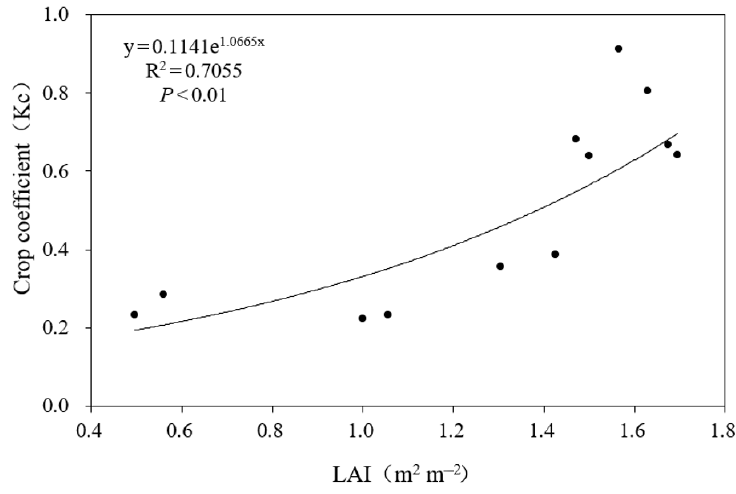
Figure 6. The relationship between leaf area index of apple trees and crop coefficient Kc during the growth period in 2019 and 2020.